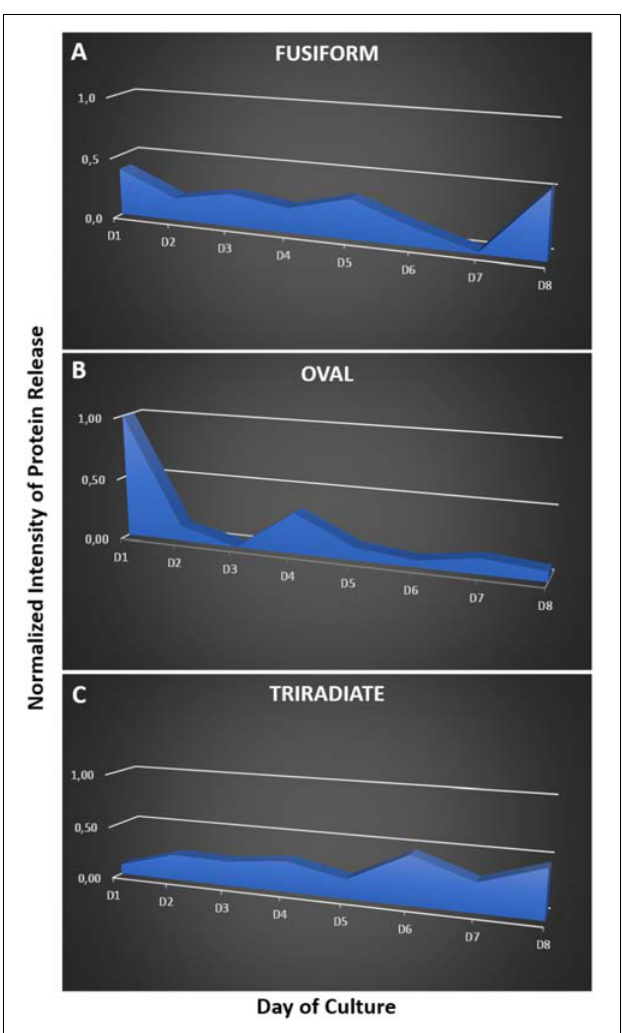
FIGURE 7 | Kinetics of protein release by the three morphotypes of P. tricornutum Pt3 strain over a 8 days period of culture. The proteins present in the culture medium of fusiform (A) , oval (B) , and triradiate (C) were separated by SDS-PAGE. Proteins in the gel were labeled with silver staining. Relative quantification of stained proteins were performed with ImageJ.